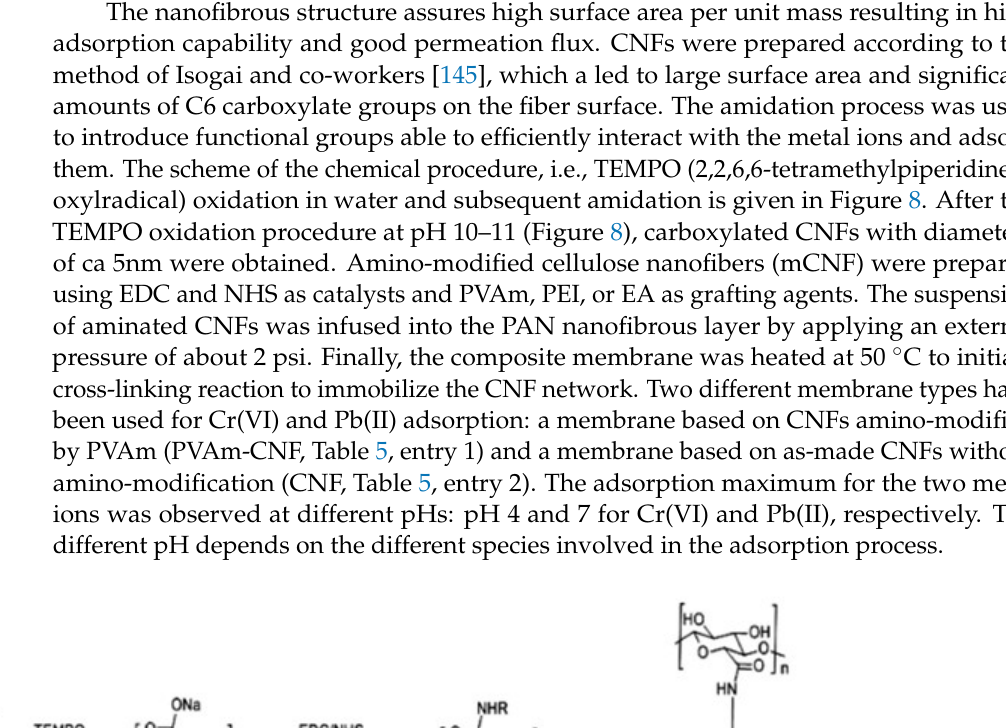
Figure 7. SEM images of electrospun PAN/PET membrane (( a ) cross-section view), and PAN/PET membrane infused with PVAm-CNF (( b ) top view). TEM image ( c ) taken at a small section of the cellulose network containing pores and individual polymer chains with a spaghetti-like configuration. Reproduced with permission from [141], copyright of Elsevier B.V.